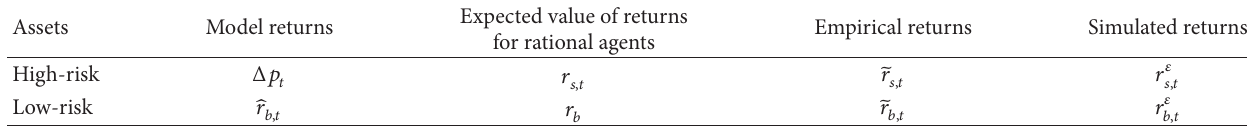
Table 2: Different types of returns.